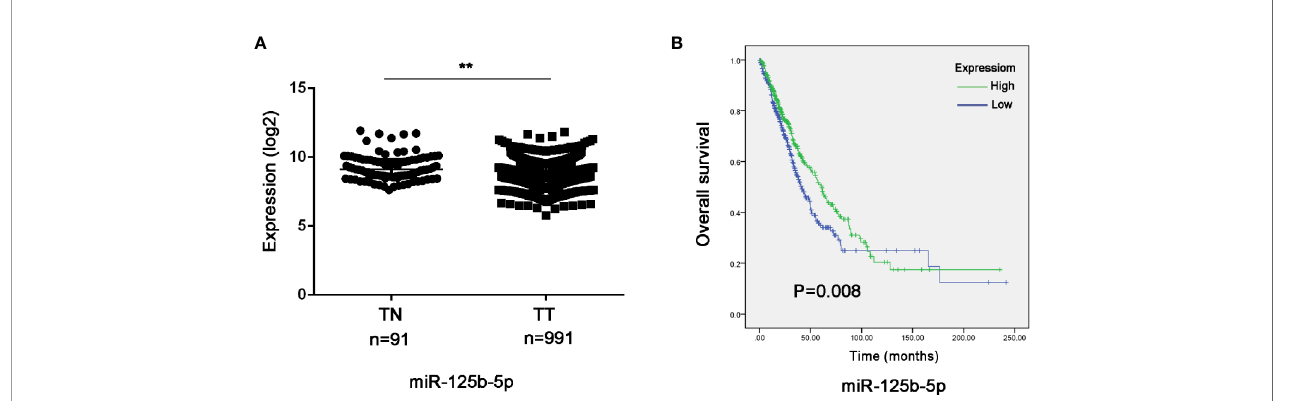
FIGURE 10 | Validation of the prognostic value of serum exosomal miR-125b-5p in NSCLC. (A) Relative expression of miR-125b-5p in NSCLC compared to normal tissue in TCGA database. (B) Kaplan-Meier survival analysis of TGCA patients with low-expression and high-expression miR-125b-5p groups. TN, normal tissue; TT, tumor tissue. (**P